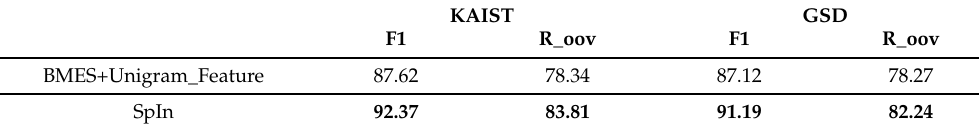
Table 5. Comparison between SpIn and previous state-of-the-art methods on the KWS task. KAIST